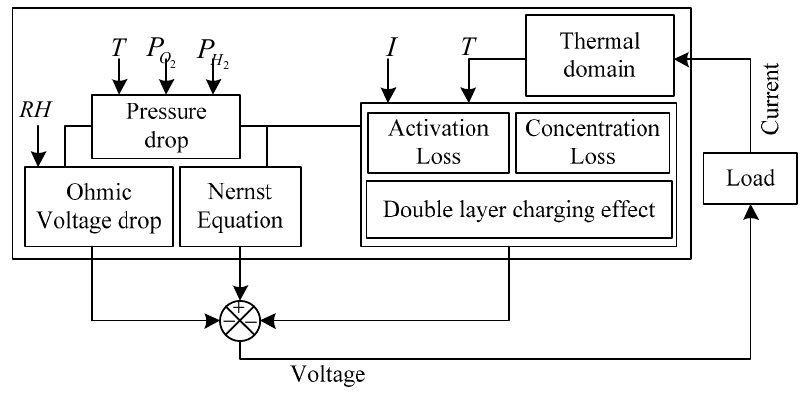
Figure 2. Dynamic elementary cell mode of PEMFC.